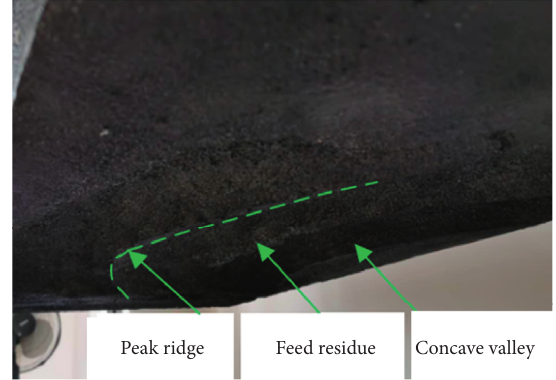
Figure 14: Simulated coal wall.